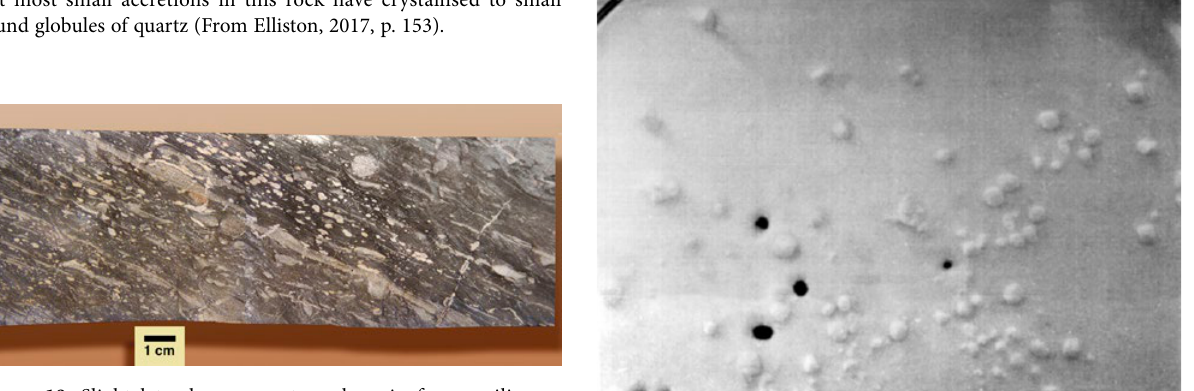
Figure 19. Slight lateral movement or shear in former siliceous ooze from the Wagga Tank drilling Mt Hope, NSW, has developed an obvious ‘porphyroidal’ texture. The elongation, distortion, and aggregation of the ovoids indicate deformation and plasticity occur- red at the soft stage in consolidation of the ooze. Wisps and shreds of cherty sediment are similarly deformed. Some quite large (1cm) accretionary nodules or ‘gel balls’ have developed (From Elliston, 2017, p.311).